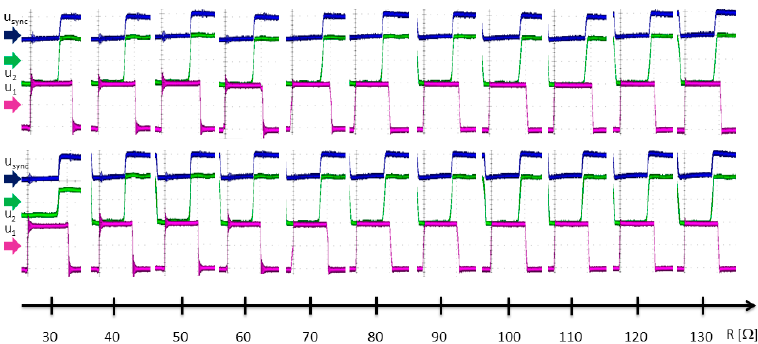
Figure 11. Phase shift with ( bottom ) and without ( upper ) application of the proposed frequency tracking algorithm.